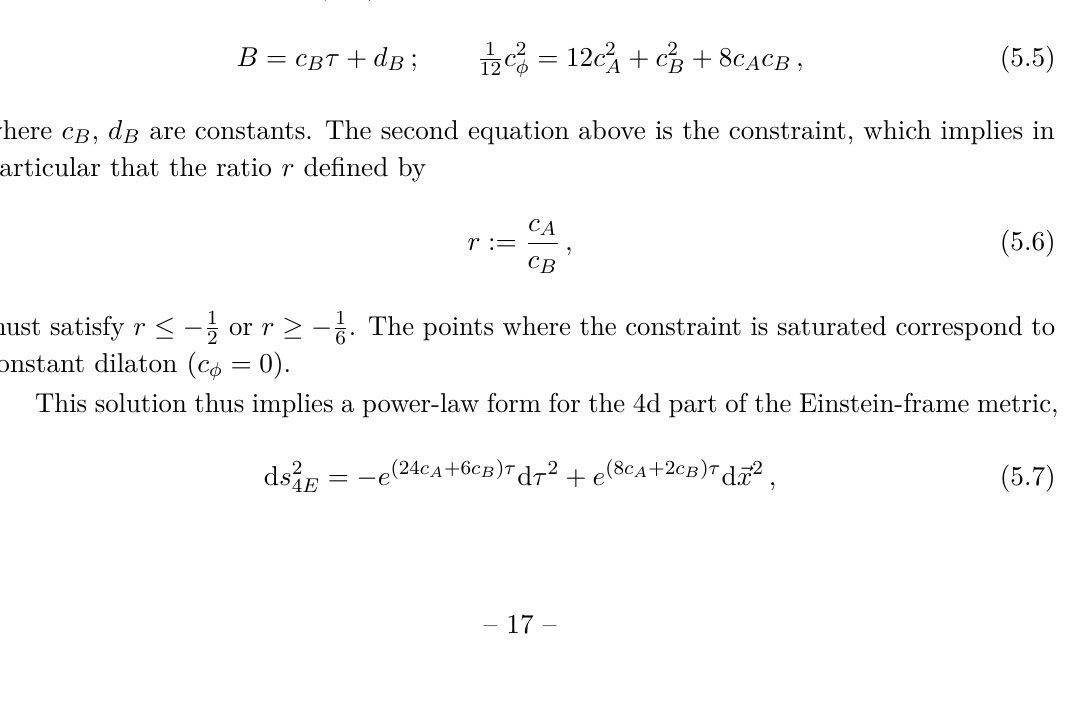
for some constants c